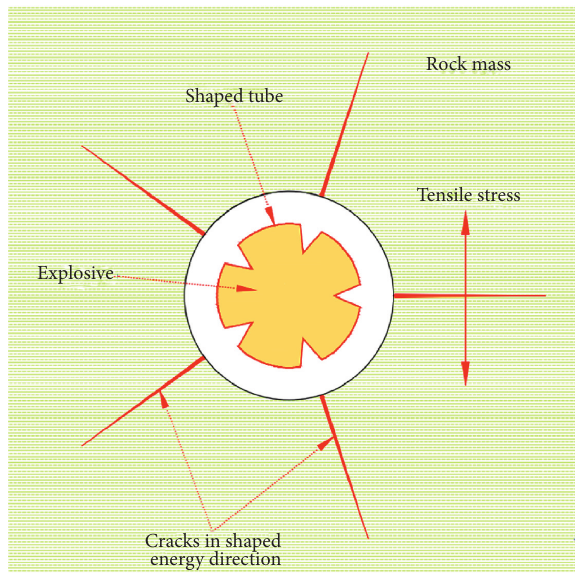
Figure 2: Multidirectional shaped charge jet penetrating rock